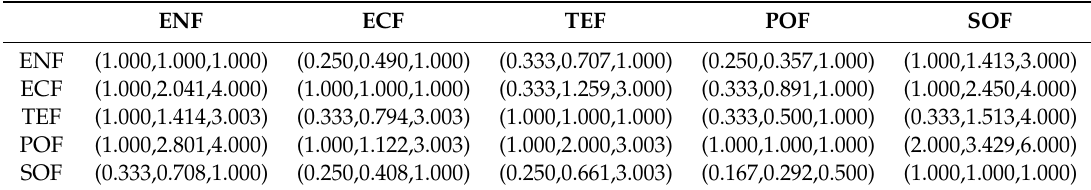
Table A3. Fuzzy pairwise comparison with respect to the selection of RE sources.